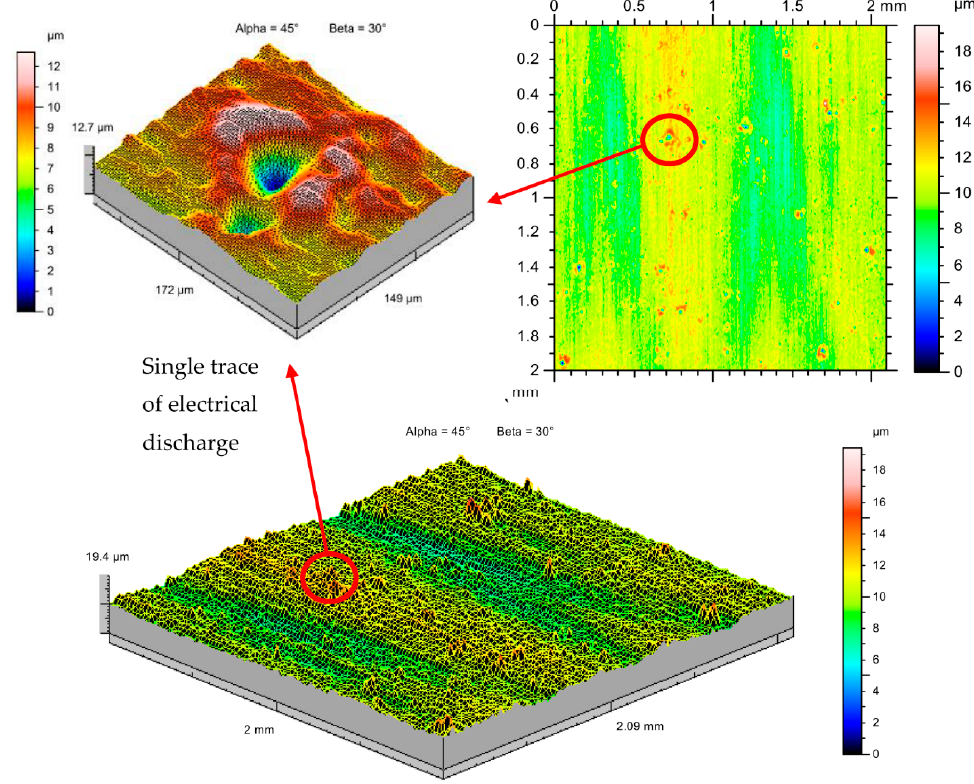
Figure 4. The surface texture of the tool steel 55NiCrMoV7 after powder mixed electrical discharge machining (PMEDM) in dielectric with 2% RGO; U c = 25 V, I = 3 A, t on = 15 µs, t off = 10 µs, machining (PMEDM) in dielectric with 2% RGO; U c = 25 V, I = 3 A, t on = 15 µ s, t off = 10 µ s, manufacturing time = 60 s. manufacturing time = 60